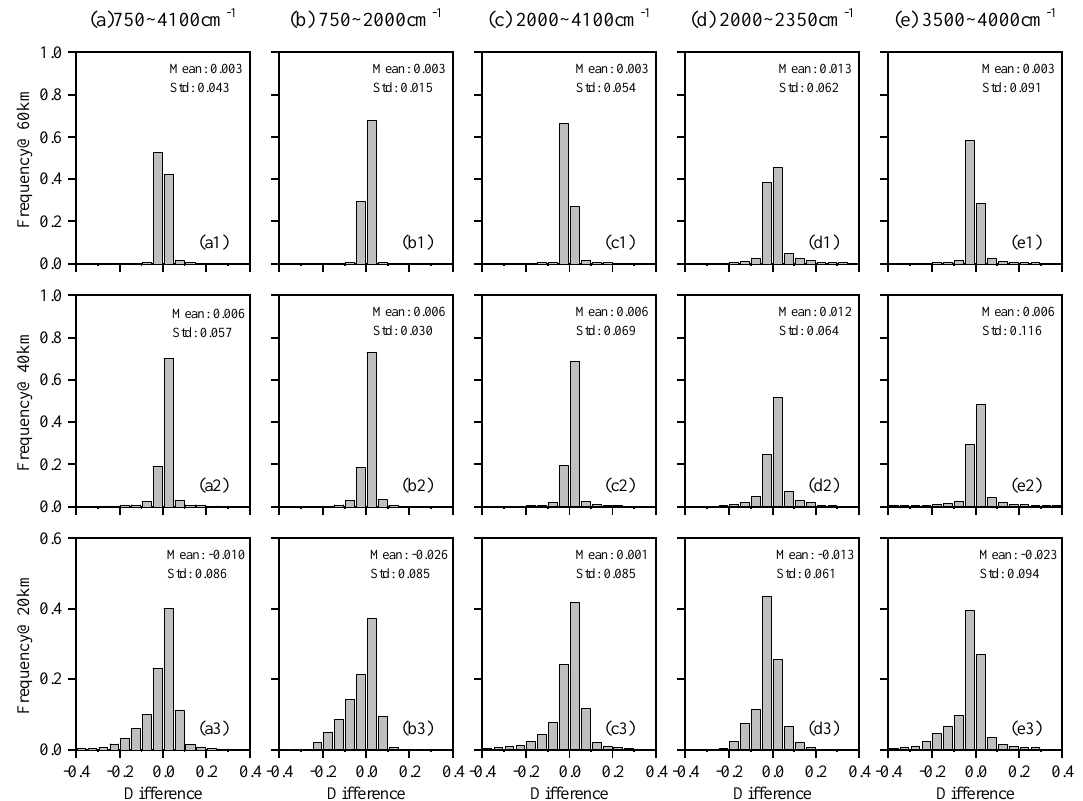
Figure 3. The frequency distribution histograms of the transmittance differences between AIUS measurements and